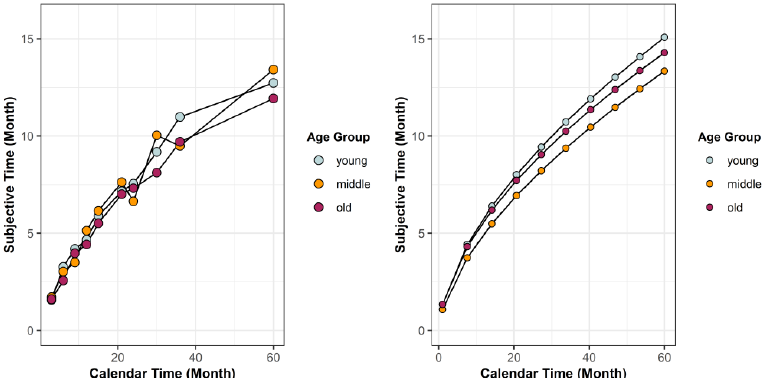
Figure 2. In the left panel, the M-estimate of location of subjective anticipatory time was plotted against calendar time for each group and for each delay. In the right panel, subjective anticipatory time for each delay was estimated using the M-estimate of location of alpha and beta for each age group. Associations between chronological age and time perception parameters for each group were shown in Table 1. Previous studies [46,68] suggested that an increase in alpha and a decrease in beta were associated with higher discounting rates. If so, developmental trajectories of time perception parameters and delay discounting were consistent among young adults. Thus, decreasing alpha and increasing beta with age may explain the neg- ative age effect on delay discounting among young adults. However, two additional find- ings indicated that this argument needed to be taken with a grain of salt. First, though the trends in the associations between delay discounting and time parameters were consistent with those of Kim and Zauberman ’ s study [46], these two associations failed to reach sta- tistical significance in the total sample (alpha, 𝜏 = 0.07, p = 0.20; beta, 𝜏 = −0 .06, p = 0.27). Second, age differences in alpha and beta did not predict developmental trajectories of delay discounting among middle-aged and older adults, which indicated that anticipatory time perception was not an important factor for determining delay discounting over life- span. So far, the underlying mechanism under which chronological age affected delay dis- counting remained unclear. Given the association between physical age and delay dis- counting, we hypothesized an incremental effect of age bias (discrepancy between subjec- tive age and chronological age) on delay discounting, which may further indicate a po- tential association between health conditions and delay discounting. Therefore, we calcu- lated age bias scores by subtracting chronological age from physical age. A positive score indicated that the participant believed him or that she was older than he or she actually was. In Model 2 (see Table 2), there was a significant interaction between age bias scores and age group after controlling the age effect. Among older adults, participants who sub- jectively felt they were older physically exhibited higher discounting rates. This interac- tion was insignificant for age bias score based on psychological age ( b = 0.06, t = 1.48, p = 0.14). The results unraveled the possibility that physical health conditions might underpin the possible regulatory mechanism behind the age-delay discounting association, as peo- ple might feel they are older because of their poor health conditions. Indeed, subjective physical health negatively correlated with age bias scores at all ages, 𝜏 = −0 .21, p < 0.001. Thus, we hypothesized that older adults who were in poorer physiological conditions felt that they were older and thus were more preferred smaller but sooner rewards. As pre- dicted, the indirect effect of physical health to delay discounting via physical age was sig- nificant (Figure 3), a × b = −0 .13, bootstrap 95% CI [ −0 .32, −0 .001]. In contrast, delay